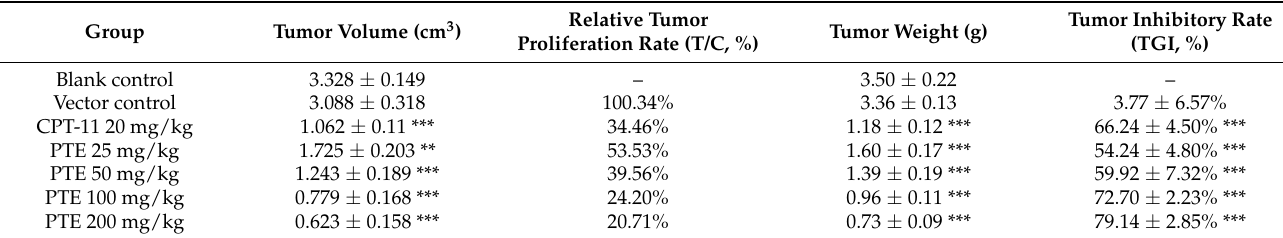
Figure 8. PTE suppressed tumor growth in subcutaneous CL187 xenograft nude mice. ( A ) Tumor volume. ( B ) Photograph of dissected tumor tissue. ( C ) Tumor weight. ( D ) Tumor inhibition Ie. ( E ) Relative gray value analysis of WB results for protein content of Top1 and Tdp1 in tumors tissues. Loading was normalized based on the level of the internal control, β -actin. ( F ) The expression levels of Top 1 and Tdp 1 in tumor tissues. Tumor of each animal were tested three times in parallel, with three replicates for each time. After the completion of the test, the average value was taken to draw the mRNA expression maps, and each point represented an animal. * p < 0.05, ** p < 0.01, and *** p < 0.001 vs. vector control. # p < 0.05, ## p < 0.01 and ### p < 0.001 vs. CPT-11 group. ns, not significant. Data are mean ± SD, n = 6. Table 2. The tumor inhibition rate of each administration group in subcutaneous CL187 xenograft nude mice (Mean ± SD, n =